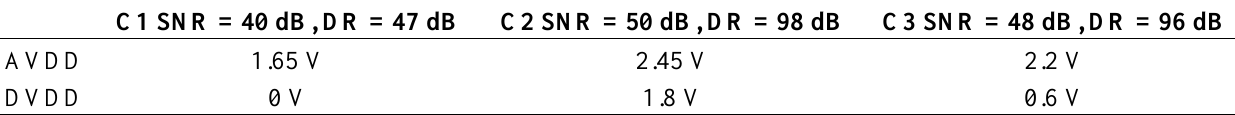
Table 1. AVDD and DVDD values to reach Minimal, Nominal and Optimal SNR and